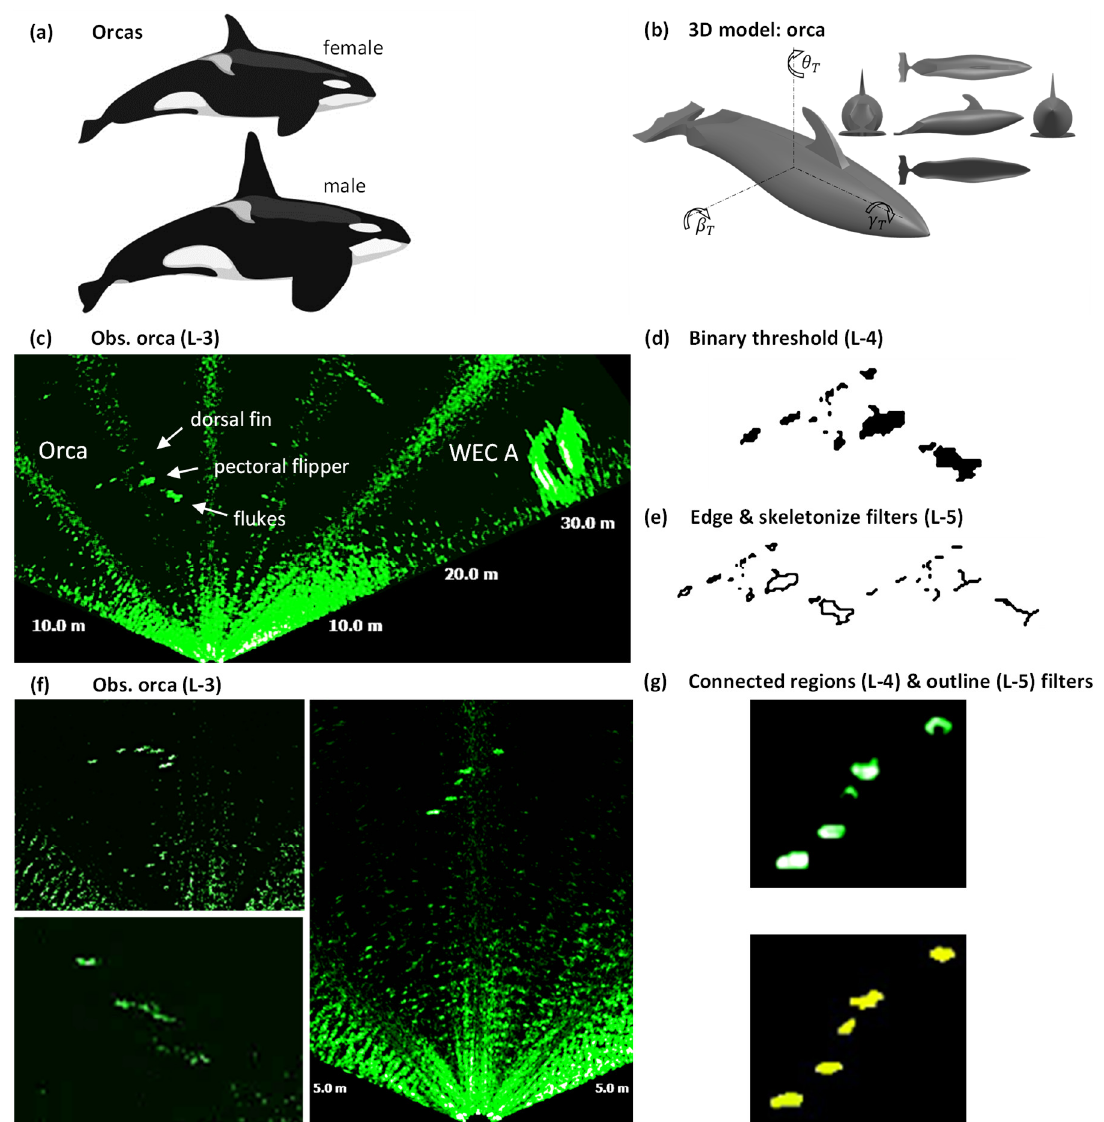
Figure 8. ( a ) Image of male and female orcas [38]. ( b ) Three dimensional model of an orca. ( c and f ) Acoustic images of an orca processed at level 3: ( c ) An orca with 7 m of length, located at 16 m of range, ( f ) Orca with 4.2 m of length, at 15 m of range. The shape and silhouette of orcas processed using ( d ) binary threshold, ( e ) outline and skeletonize filters, ( g ) connected regions, and ( h ) outline filters.